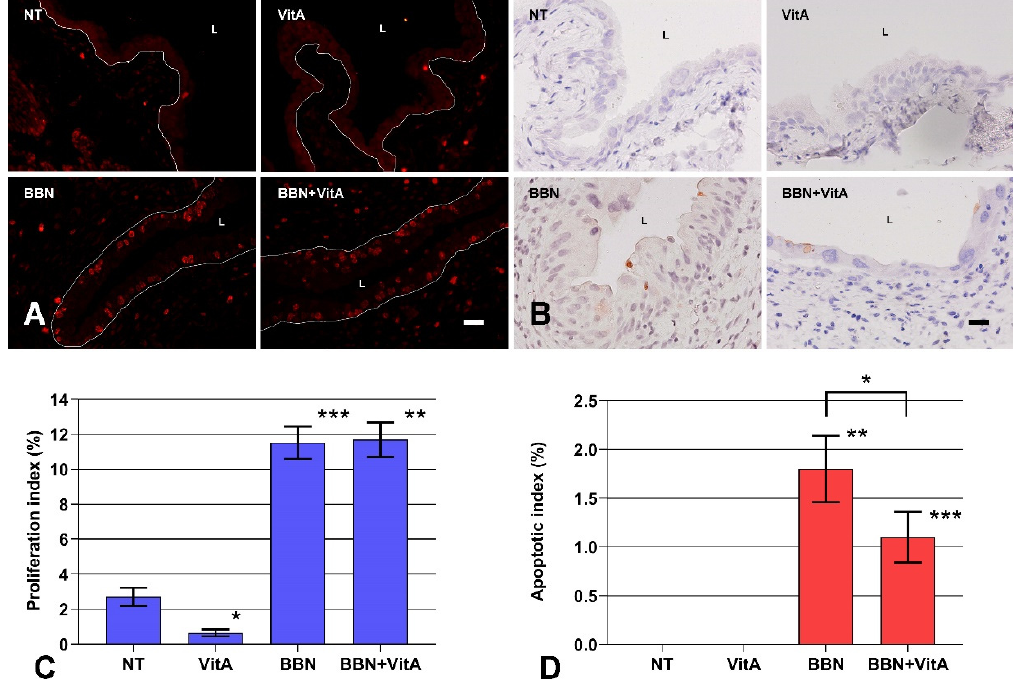
Figure 4. Proliferation and apoptosis of urothelial cells. ( A ) Ki-67 immunofluorescence (red) for identification of proliferating cells. Red nuclei are Ki-67 positive nuclei from proliferating cells; white line depicts the location of basal lamina. L, lumen. Scale bar = 50 μ m. ( B ) Active caspase-3 immunohistochemistry (brown) for identification of apoptotic cells. Brown cells are active caspase-3 positive cells dying via apoptosis. Scale bar = 50 μ m. ( C ) Proliferation indices of urothelial cells in NT ( n = 6), VitA ( n = 6), BBN ( n = 12), BBN + VitA ( n = 12). Statistically significant differences (tested by ANOVA, F-test, and two-sided Student’s t test) were determined between NT and VitA (* p = 0.0062) and between NT and BBN (*** p = 2.22 × 10 − 9 ) and VitA and BBN + VitA (** p = 3.98 × 10 − 9 ). There was no statistically significant difference between BBN and BBN + VitA; ( D ) apoptotic index of urothelial cells in NT ( n = 6), VitA ( n = 6), BBN ( n = 12), BBN + VitA ( n = 12). Statistically significant differences (tested by ANOVA, F -test, and two-sided Student’s t test) were determined between NT and BBN (** p = 0.0032) and VitA and BBN + VitA (*** p = 0.00047), and between BBN and BBN + VitA (* p = 0.049).